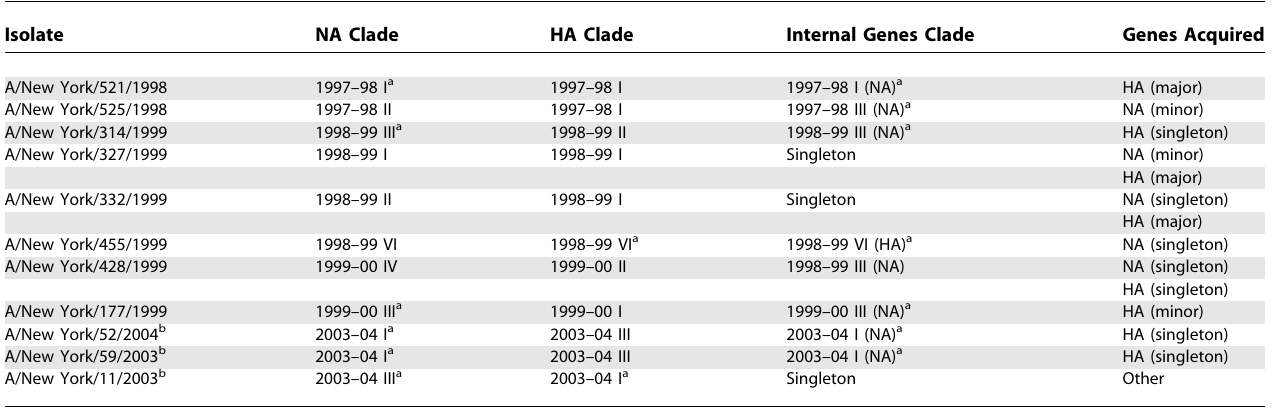
Viruses Sampled from New York State and Globally during 1997– 2005, with All Sequence Labels Depicted The tree is midpoint rooted for purposes of clarity and all horizontal branch lengths are drawn to scale. Found at doi:10.1371/journal.ppat.0020125.sg002 (136 KB PDF). Figure S3. Phylogenetic Relationships of the HA Gene of Influenza Viruses Sampled from New York State and Globally during 1997– 2005, with All Sequence Labels Depicted The tree is midpoint rooted for purposes of clarity and all horizontal branch lengths are drawn to scale. Found at doi:10.1371/journal.ppat.0020125.sg003 (111 KB PDF). Figure S4. Phylogenetic Relationships of the Concatenated Internal Genes of Influenza Viruses Sampled from New York State and Globally during 1997–2005, with All Sequence Labels Depicted The tree is midpoint rooted for purposes of clarity and all horizontal branch lengths are drawn to scale. Found at doi:10.1371/journal.ppat.0020125.sg004 (72 KB PDF). Table S1. Data Used in This Study: 413 Isolates of Human H3N2 Influenza A Virus Sampled from New York State, 1997–2005 The GenBank accession numbers shown are for the PB2 gene only. Accession numbers for the remaining segments of each viral isolate are available at NCBI’s Influenza Virus Resource: http://www.ncbi.nlm. nih.gov/genomes/FLU/Database/select.cgi. Table S2. Global Background H3N2 Isolates, 1997–2005: NA Gene, 140 Sequences Table S3. Data Used in This Study: Global Background H3N2 Isolates, 1997–2005: HA Gene, 48 Sequences